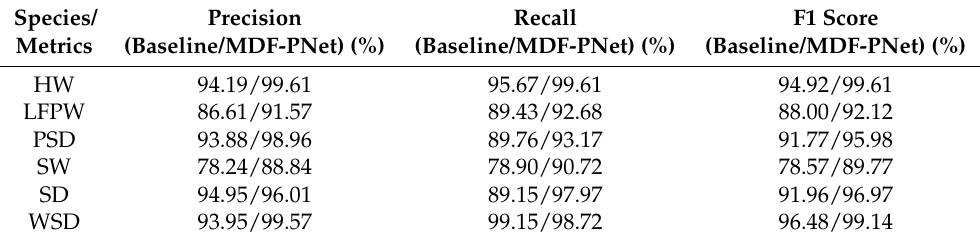
Table 4. Comparison of statistical metrics performance between baseline and